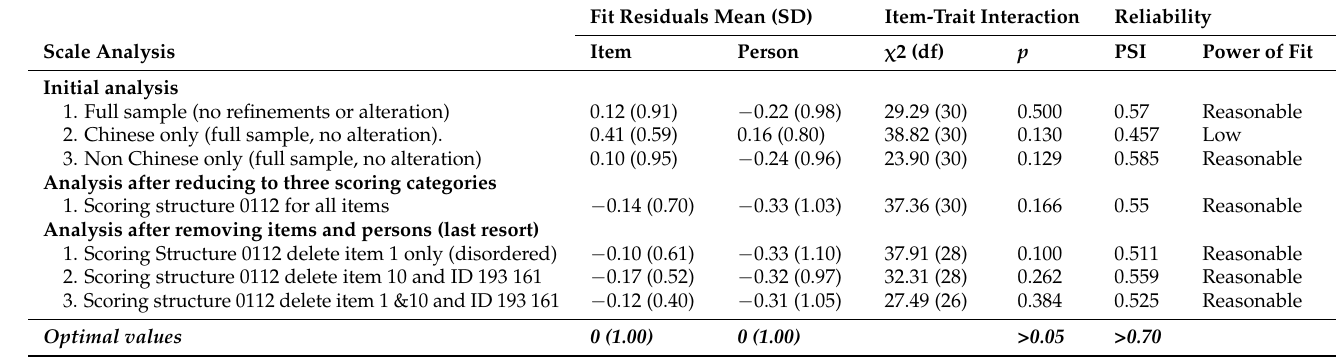
Table 2. Fit residuals, item–trait interaction, and reliability for different modifications of the